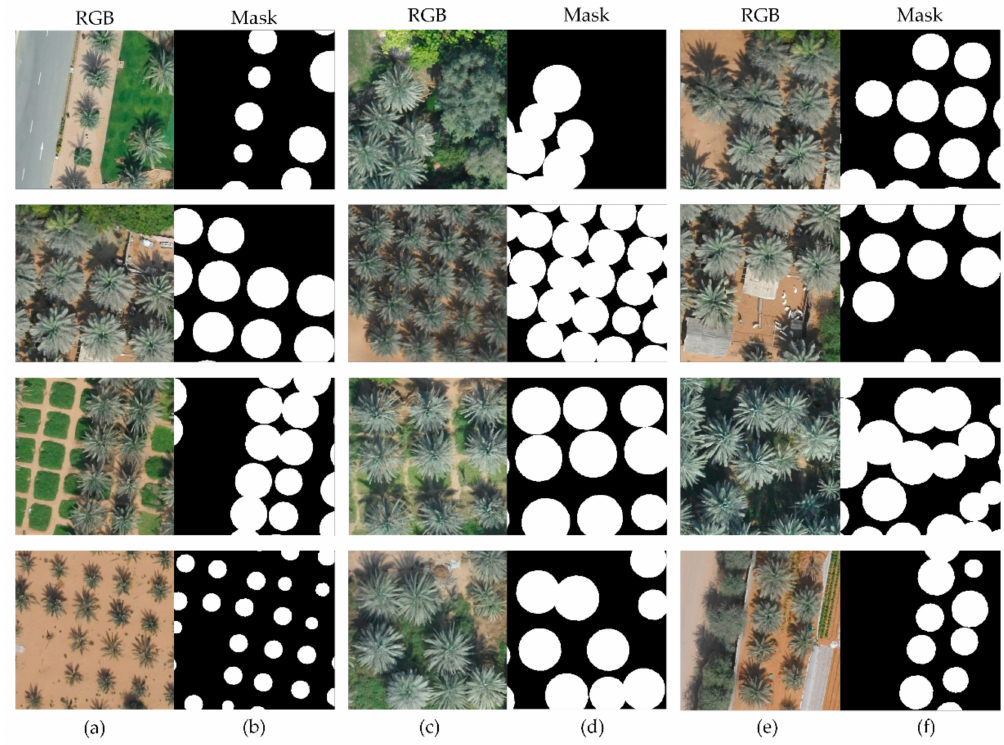
Figure 2. Samples of different image-label pairs: ( a , c , e ) image tiles and ( b , d , f ) their corresponding